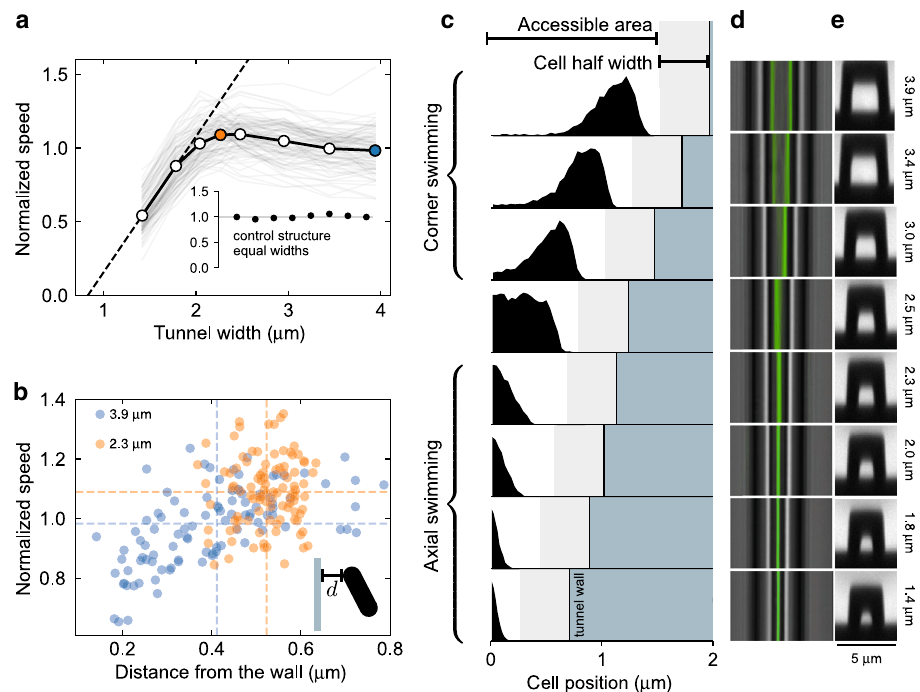
Fig. 2 Stable swimming on the microtunnel axis enhances bacterial motility in narrow constrictions. a Swimming speeds of E. coli cells as a function of microtunnel widths. Individual cell speeds are normalized to the free values measured outside of the structure and are reported as gray lines. Open circles represent speed averages on 100 cells. The dashed line is a linear extrapolation reaching zero speed for a tunnel width of 0.83 μ m. The inset plots the results of a control experiment where speed is measured in a structure where all the tunnels widths are 3 μ m. Symbol sizes are comparable with the standard errors. b Normalized speed vs mean distance from the tunnel wall for each cell in the two tunnels with widths of 3.9 μ m (blue) and 2.3 μ m (orange). c Distributions of the cell centroids positions measured from the tunnel axis. A transition to stable axial swimming is observed for tunnel widths below 2.5 μ m. The maximum speed in panel a corresponds to the largest tunnel for which axial swimming is stable. d Central sections of all the tunnels with the trajectories of all the bacteria superimposed are shown. e Cross-sections of the tunnels obtained by two-photon microscopy (see Supplementary Note